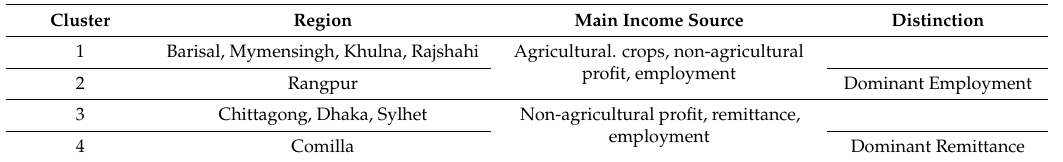
Table 4. Cluster characteristics of main income sources, by region.